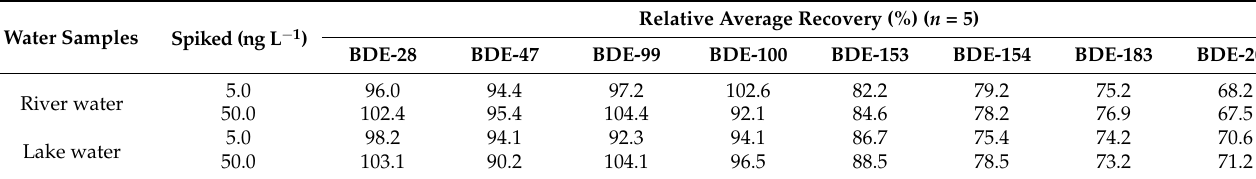
Table 3. Results of determination and standard deviations of PBDEs from spiked river and lake water